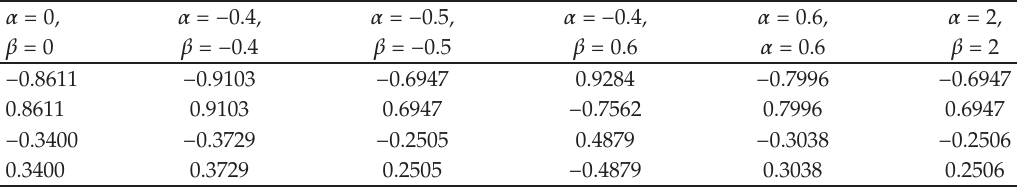
(cid:3) α,β (cid:4)